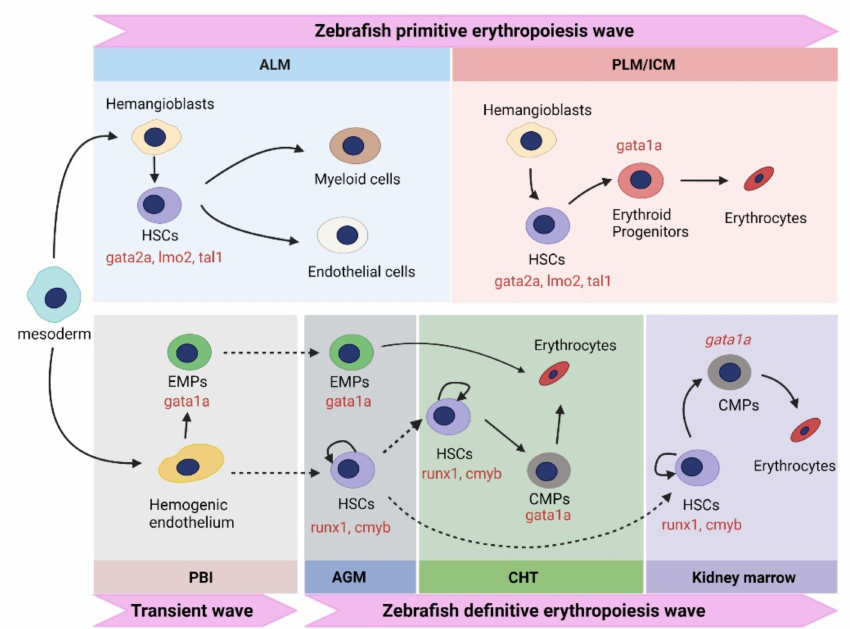
Figure 1. Primitive and definitive erythropoiesis in zebrafish. Primitive erythropoiesis is shown on the top. The transient wave and definitive erythropoiesis are shown at the bottom. Transcription factors critical to erythropoiesis are shown in red. Dotted arrows represent migration, while solid arrows stand for differentiation or self-renewal. HSC, hematopoietic stem cell; ALM, anterior lateral mesoderm; PLM; the posterior lateral mesoderm; ICM, intermediate cell mass; EMPs, erythro- myeloid progenitors; CMP, common myeloid progenitors; PBI, posterior blood island; AGM, aorta– gonad–mesonephros; CHT, caudal hematopoietic